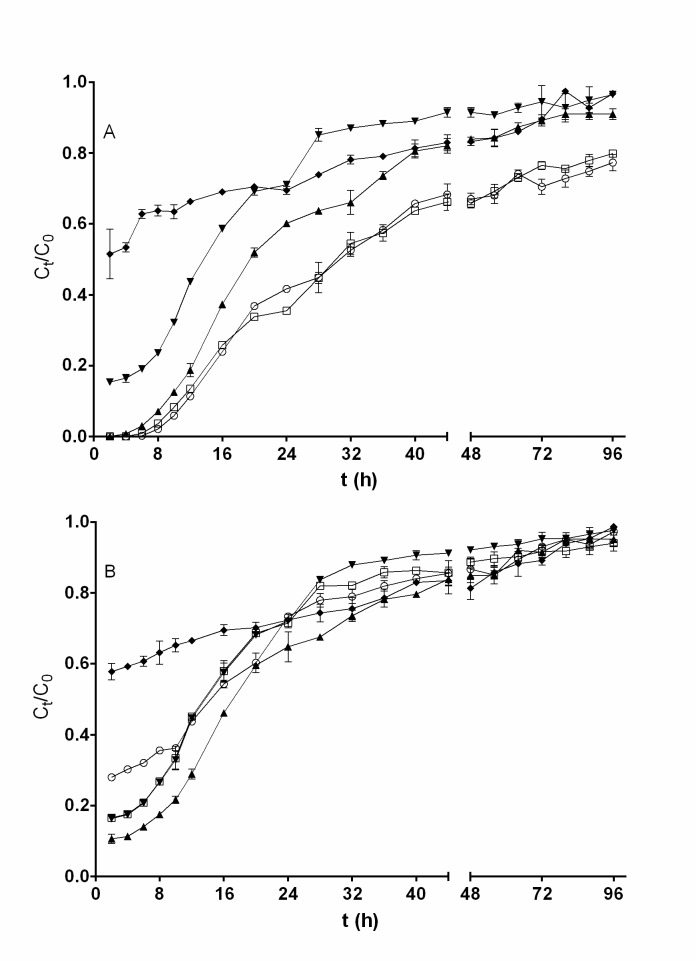
Influence of influent pH on the breakthrough curve for removal of Cr(VI) (A) and total chromium (B) by QCS [influent pH: ○, 1.0; □, 1.5; ▲, 2.0; ▼, 2.5; ◆, 3.0]. Conditions: influent Cr(VI) concentration, 200 mg L−1; influent flow rate, 0.75 mL min−1; bed height, 3.5 cm. When they do not appear, standard deviation bars are smaller than the size of the symbols.